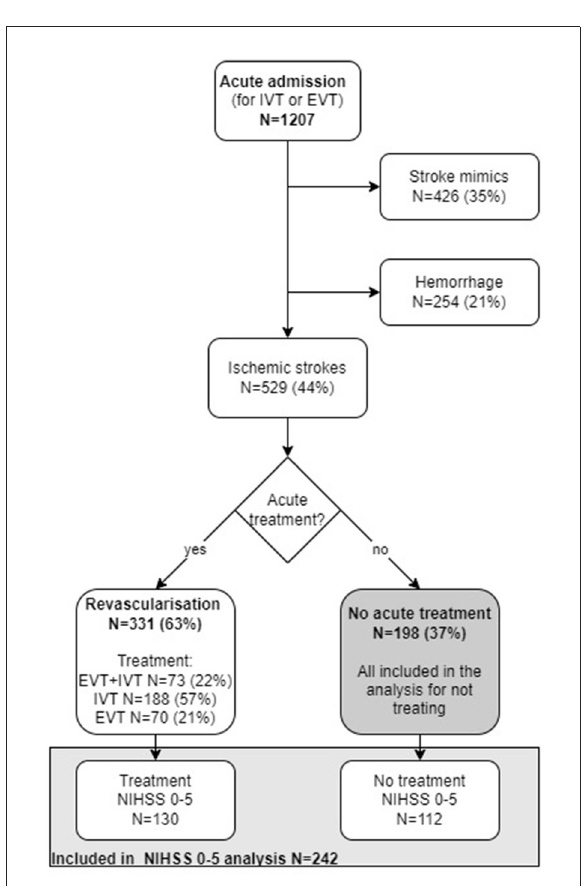
FIGURE2 Flow chart illustrating number of acute admissions (N). IVT, Intravenous thrombolysis; EVT, endovascular treatment; NIHSS, National institute of health stroke